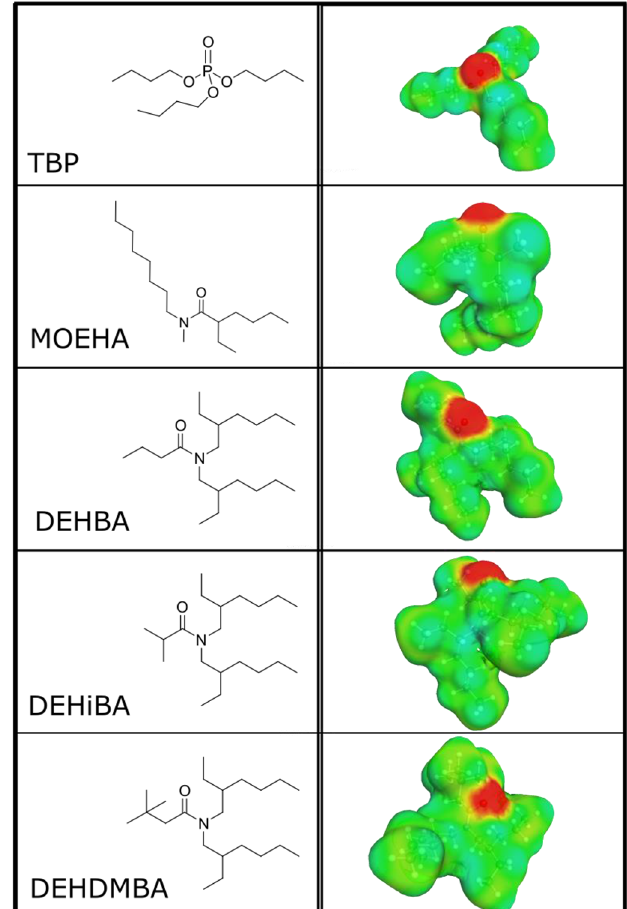
Fig. 1. Extractant structure and COSMO